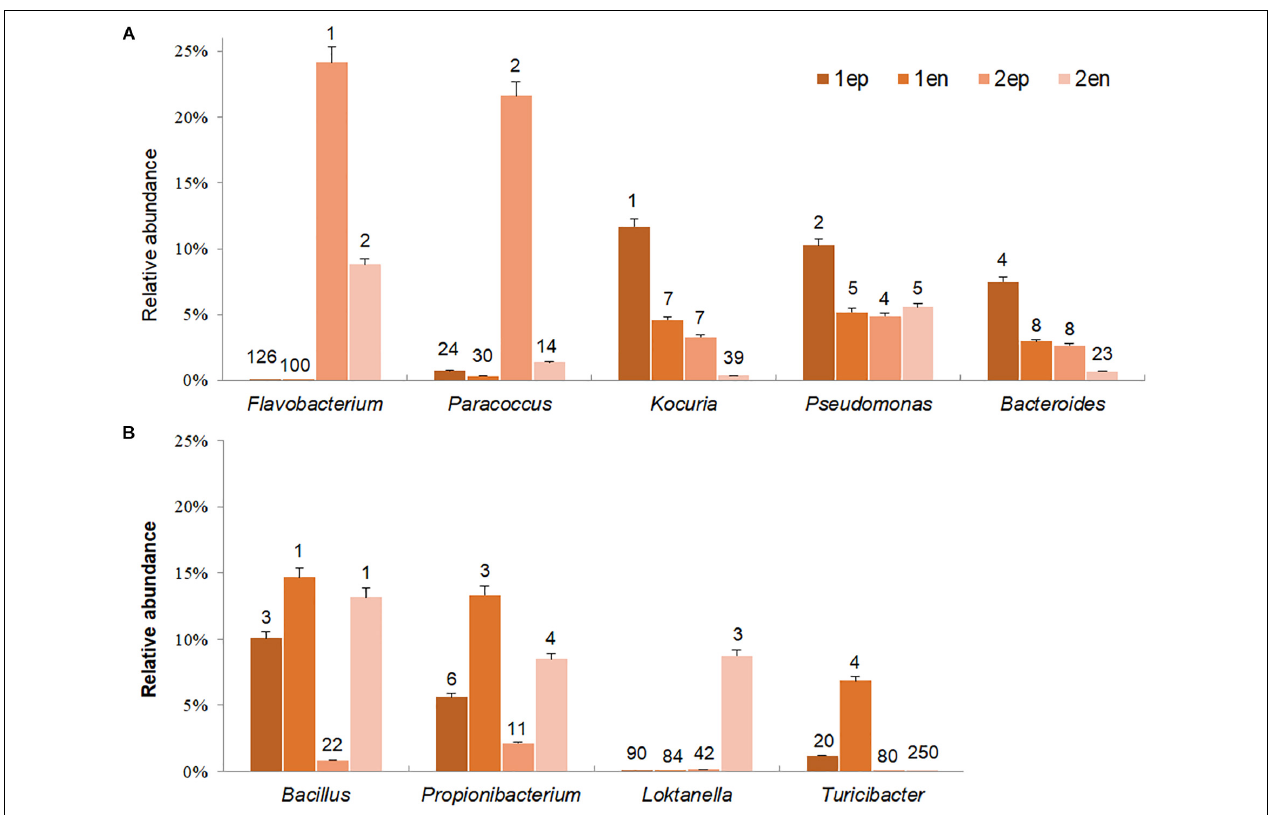
FIGURE 11 | Potential dominant epiphytic and endophytic bacterial genera in brown and yellow S. horneri . (A) Epiphytic bacterial genera. (B) Endophytic bacterial genera. The number above column indicated the rank in abundance. 1ep: all epiphytic bacteria associated with brown thallus, 1en: all endophytic bacteria associated with brown thallus, 2ep: all epiphytic bacteria associated with yellow thallus, 2en: all endophytic bacteria associated with yellow